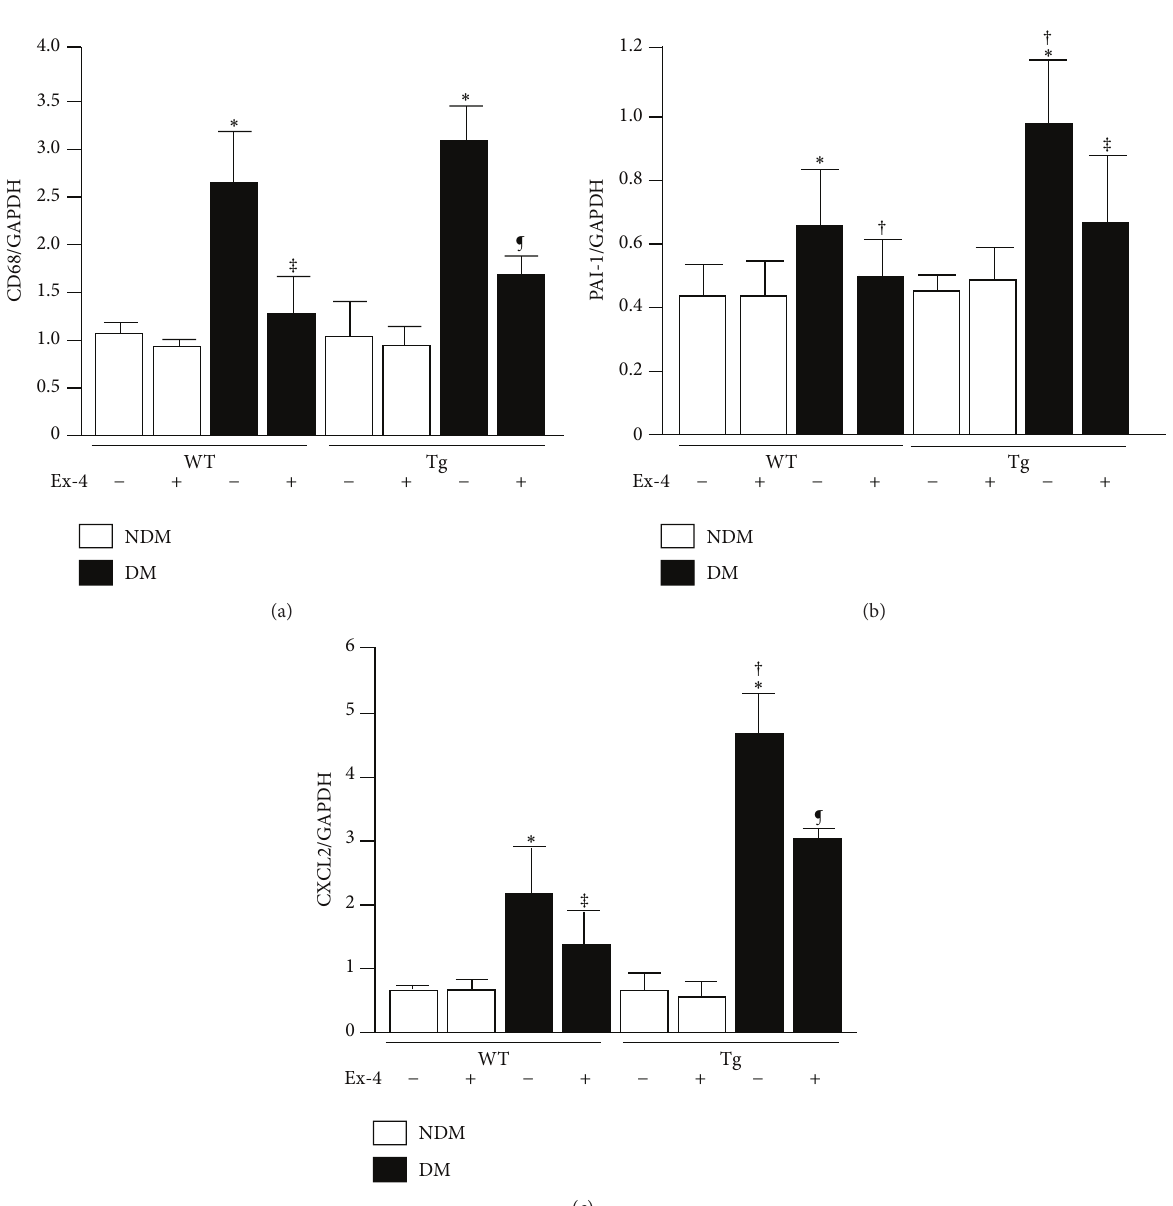
Figure 2: Effect of exendin-4 treatment on inflammatory markers in EC-PKC 𝛽 2Tg mice. (a) CD68 mRNA expression in the renal cortex of each group. ∗ 𝑃 < 0.05 versus WT/NDM/exendin-4( − ), † 𝑃 < 0.05 versus WT/DM/exendin-4( − ), and ‡ 𝑃 < 0.05 versus EC- PKC 𝛽 2Tg/DM/exendin-4( − ). 𝑁 = 6 in nondiabetic WT + vehicle, nondiabetic WT + Ex-4, diabetic WT + vehicle, diabetic WT + Ex-4, nondiabetic EC-PKC 𝛽 2Tg + Ex-4, and diabetic EC-PKC 𝛽 2Tg + Ex-4 groups; 𝑛 = 7 in nondiabetic EC-PKC 𝛽 2Tg + vehicle and diabetic EC-PKC 𝛽 2Tg + vehicle groups. (b) PAI-1 mRNA expression in the renal cortex of each group. ∗ 𝑃 < 0.05 versus WT/NDM/exendin-4( − ), † 𝑃 < 0.05 versus WT/DM/exendin-4( − ), and ‡ 𝑃 < 0.05 versus EC-PKC 𝛽 2Tg/DM/exendin-4( − ). 𝑁 = 6 in nondiabetic WT + vehicle,